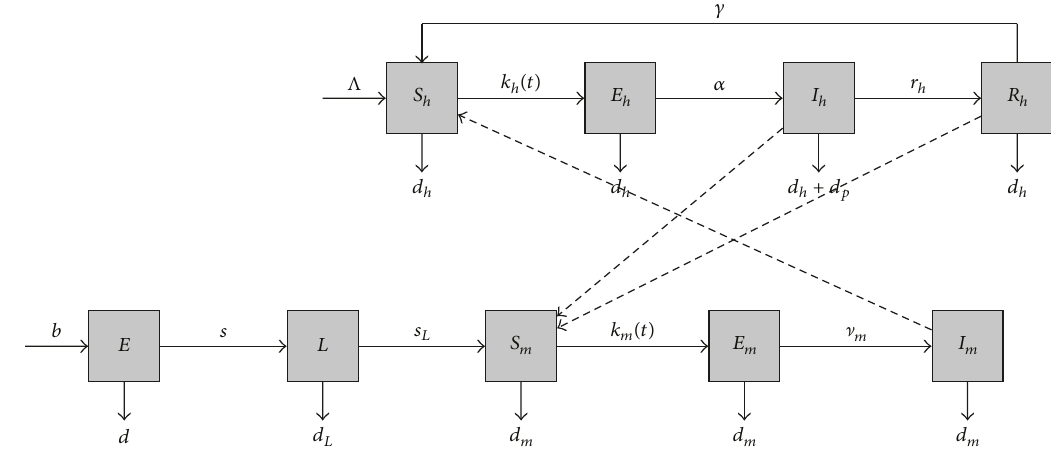
Figure 1: The dashed arrows indicate the direction of the infection and the solid arrows represent the transition from one class to another.